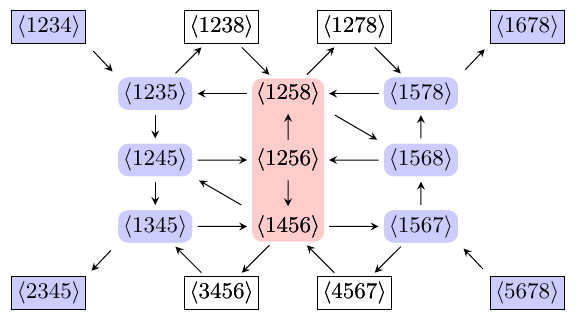
Figure 25. A cluster containing the poles of [12345][56781] in Conf 8 ( P 3 ). associated to (5.10) at ten points will be A is